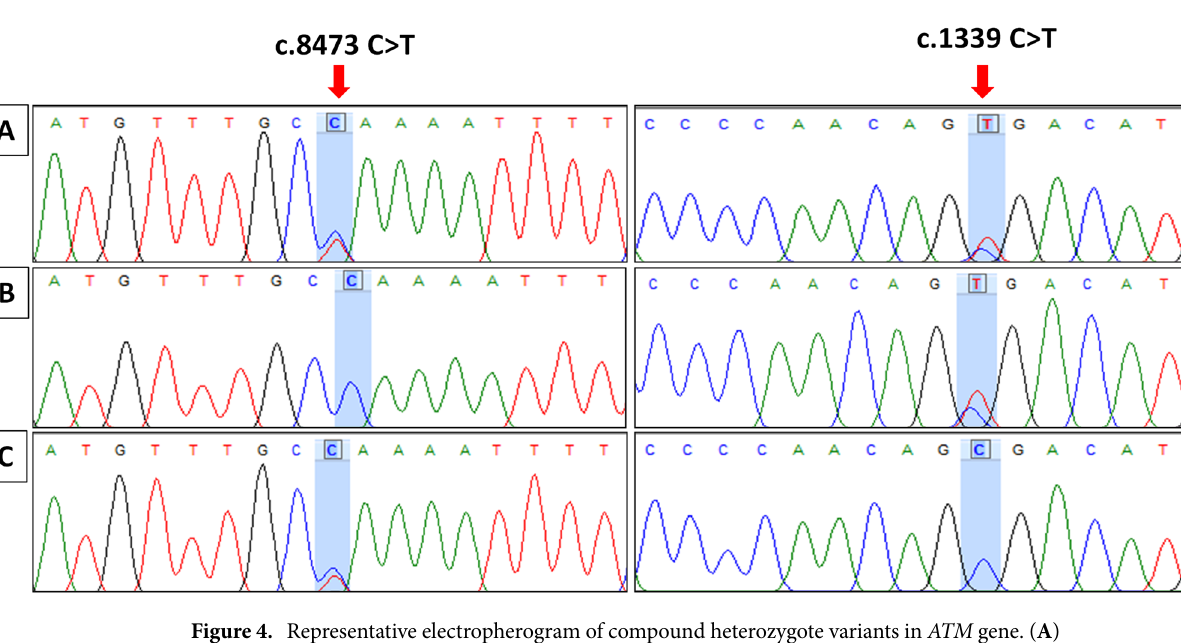
Figure 4. Representative electropherogram of compound heterozygote variants in ATM gene. ( A ) Chromatogram of Patient reveals heterozygous nonsense variant at c.8473C>T position resulting in termination of translation event at residue 2825, and c.1339 C>T variant in another allele leading to premature termination at residue 447. ( B ) Chromatogram of father revealed wild type genotype at c.8473 location (C/C) and heterozygous C/T variation at c.1339 position in another allele. ( C ) Chromatogram of mother revealed heterozygous C/T variant at c.8473 position and wild type C/C genotype at c.1339